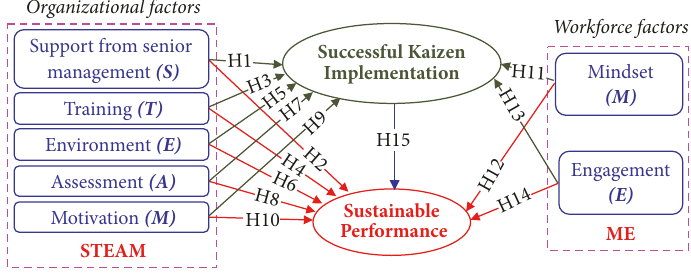
Figure 1: Proposed research